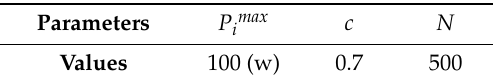
Figure 3. Job arrival numbers. Table 1. Parameters Settings.